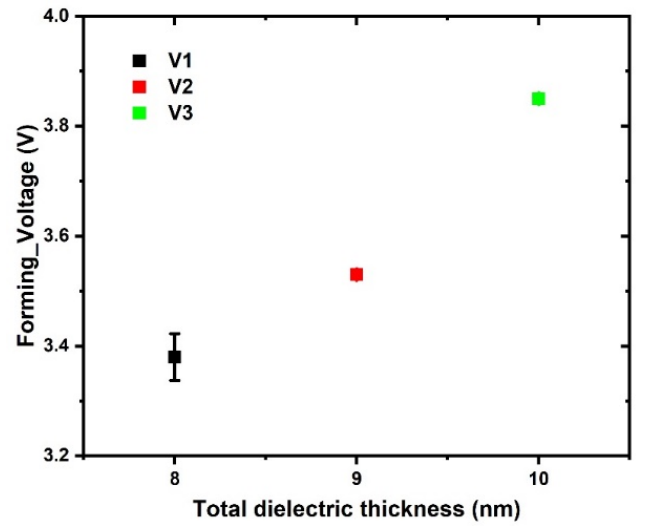
Figure 4. Mean values of forming voltages with error bars versus the total dielectric thickness of memristive device variants fabricated in 130 nm CMOS technology of IHP.